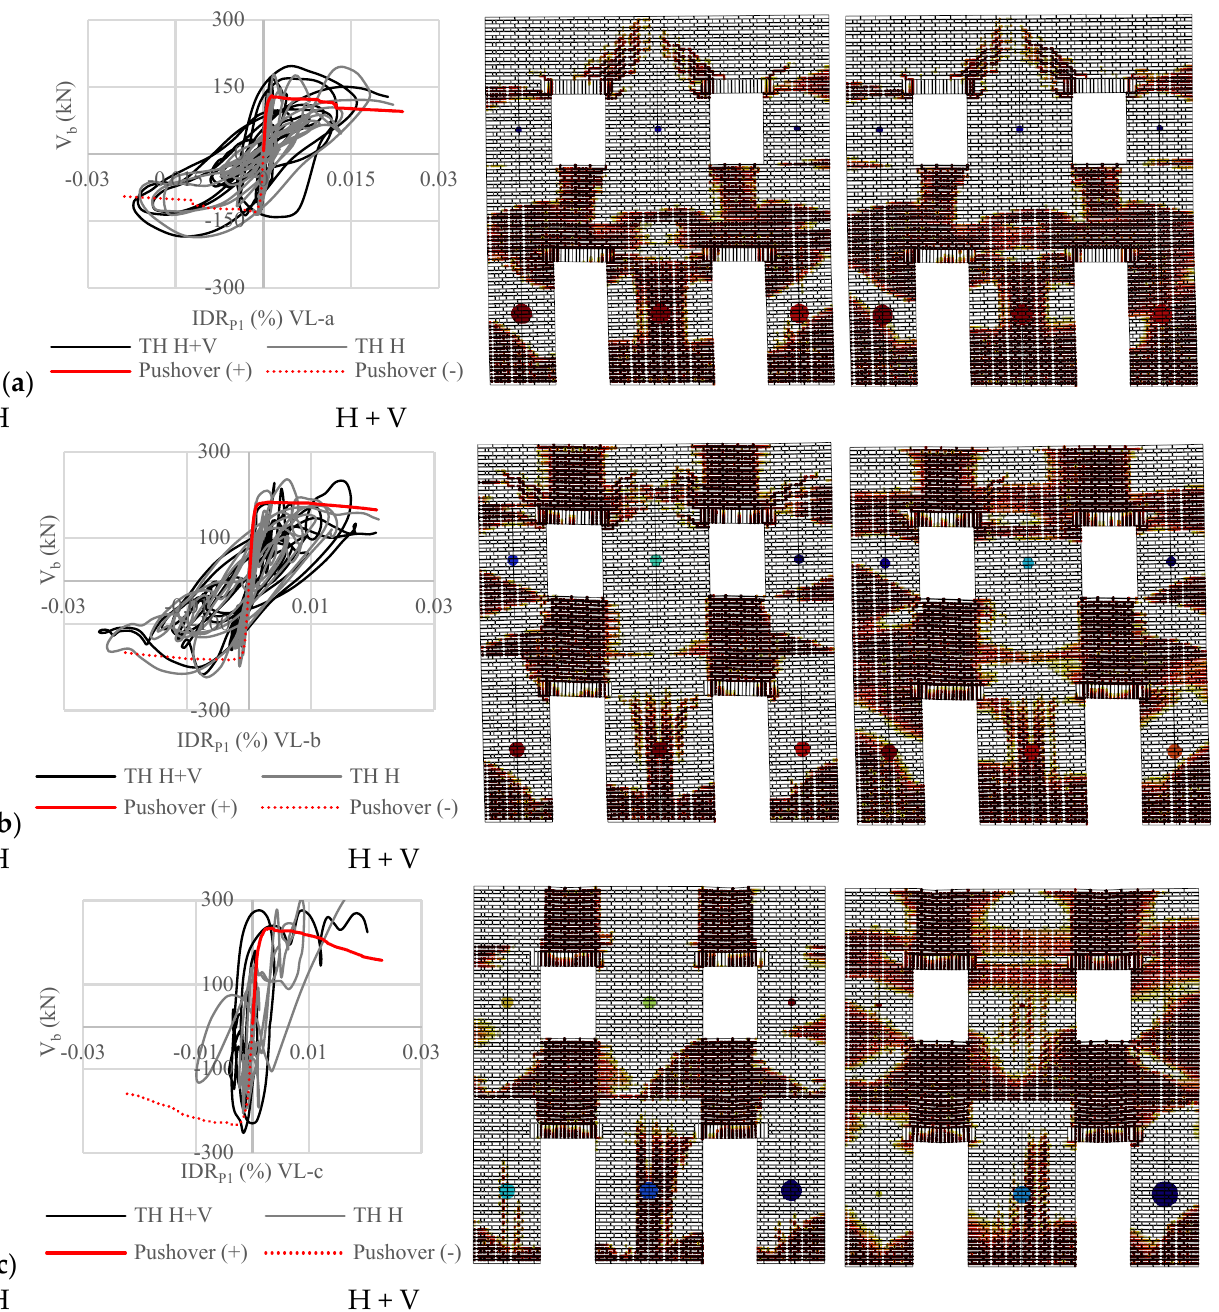
Figure 15. IDR- V b curves and crack patterns obtained for earthquake #1. TH results for the H component are in grey, TH results for H + V components are in black, the PO curve for positive displacements is the continuous red line, and the PO curve for negative displacements is the dashed red line. Loading conditions: VL-a ( a ), VL-b ( b ), and VL-c ( c ).